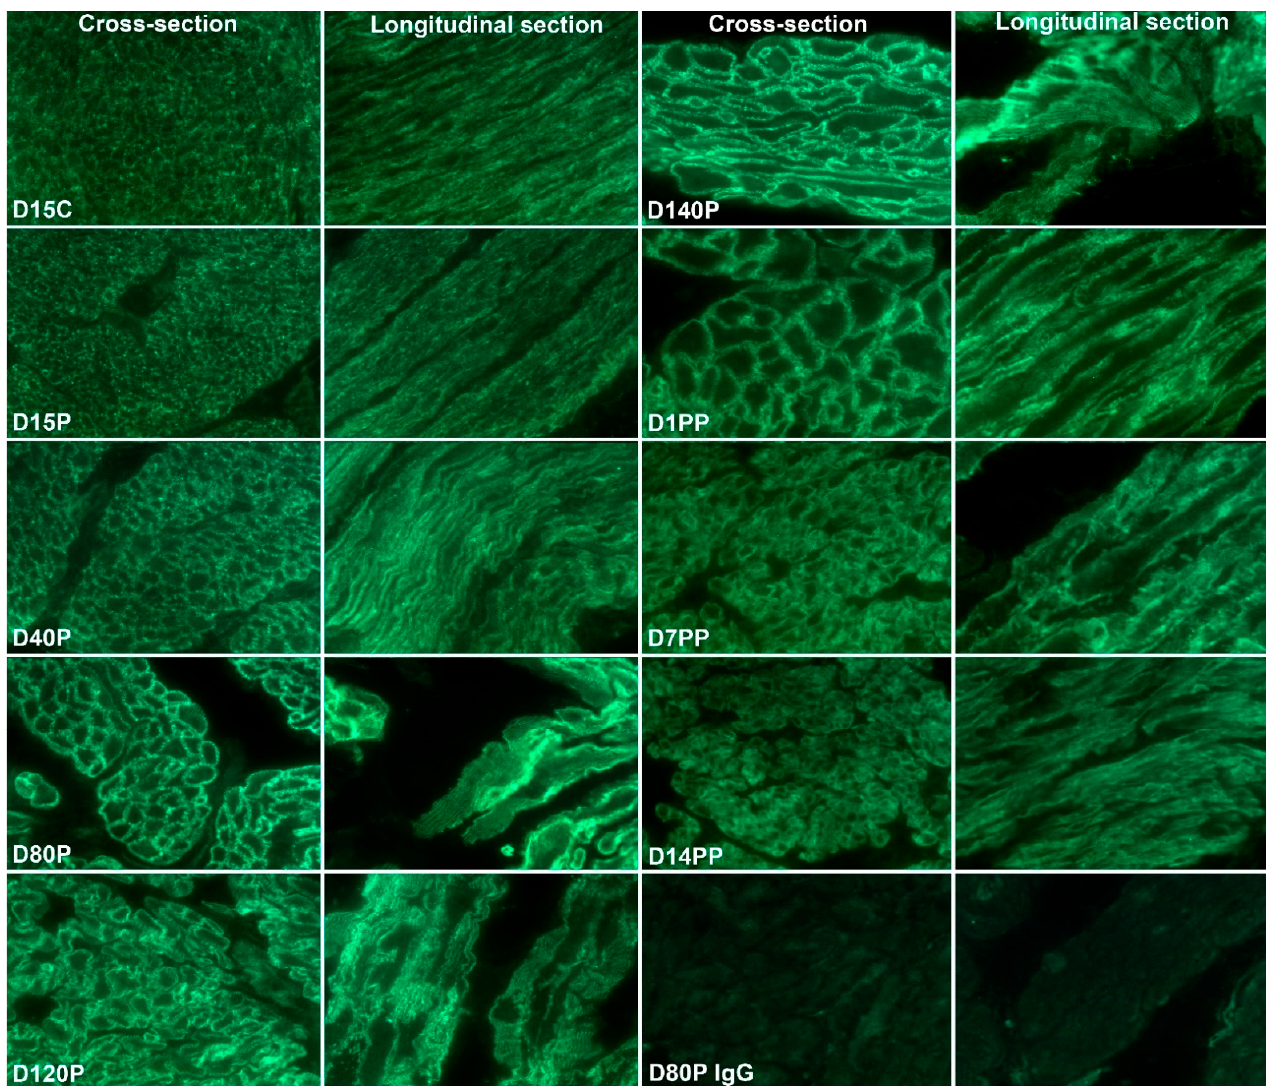
Figure 4. Immunostaining for beta 1 integrin (ITGB1) in the myometrium of ewes on Day (D) 15 of the estrous cycle (C), Days 15, 40, 80, 120, and 140 of pregnancy (P), and Days 1, 7, and 14 postpartum (PP) is shown. Note the linear strands of IACs that appear as regularly distributed spots at the myometrial cell surface present in some cells on Day 40, which are present and highly ordered on all myometrial cells on Days 80, 120, and 140 of pregnancy. These highly ordered IACs are not present on the myometrial cells on Day 15 of the estrous cycle or pregnancy and are not present in the myometrium of postpartum ewes. Views of myometrial cells cut in cross-section and in longitudinal section are shown. An irrelevant rabbit IgG served as a negative control. The width of each field is 140 µm.